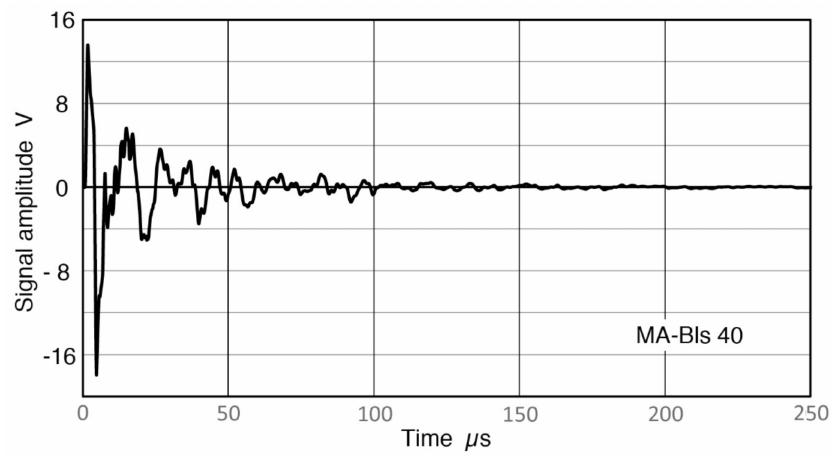
Figure 16. Receiver output waveform to 250 µ s. V189 transmitter and MA-Bls 40 receiver. Signals near noise level beyond 150 µ s can be recovered by signal averaging to 585 µ s.